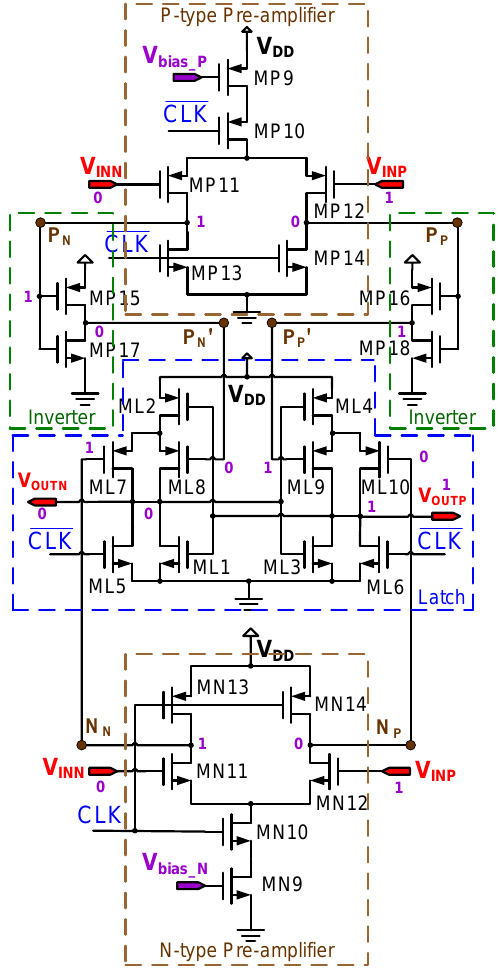
Figure 6. Complementary-input double-tail latch-type voltage comparator.